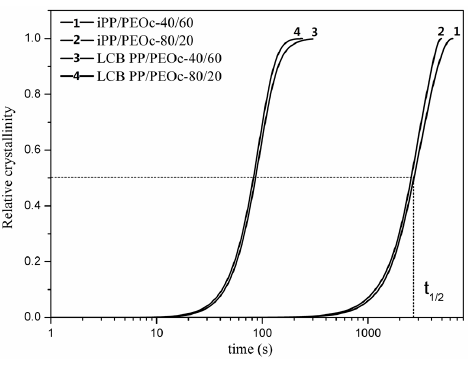
Figure 5. Relative crystallinity of iPP/PEOc and LCB PP/PEOc blends undergoing isothermal crystallization at 140 °C.